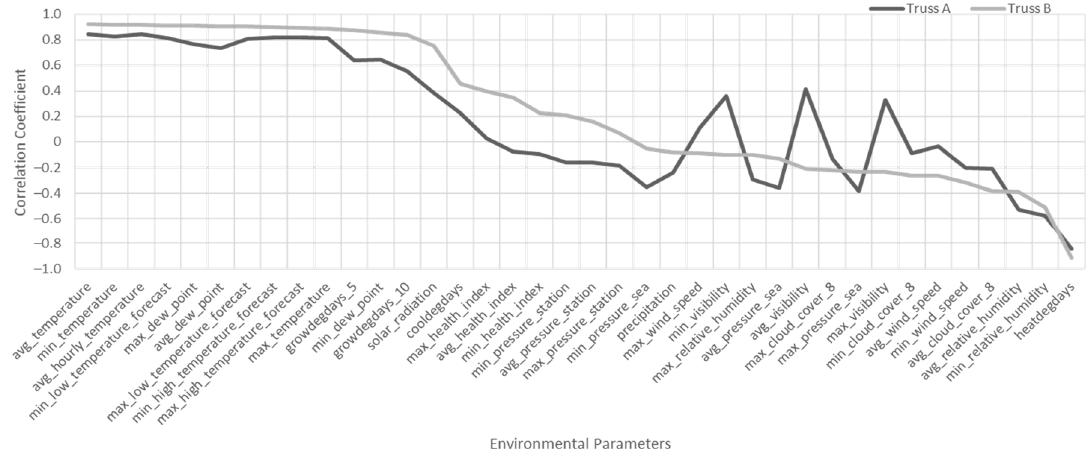
10 Table 2. Environmental parameters correlations with deflections. The results are sorted based on Truss A, and correlation class is assigned based on both Trusses. Environmental Parameter Name